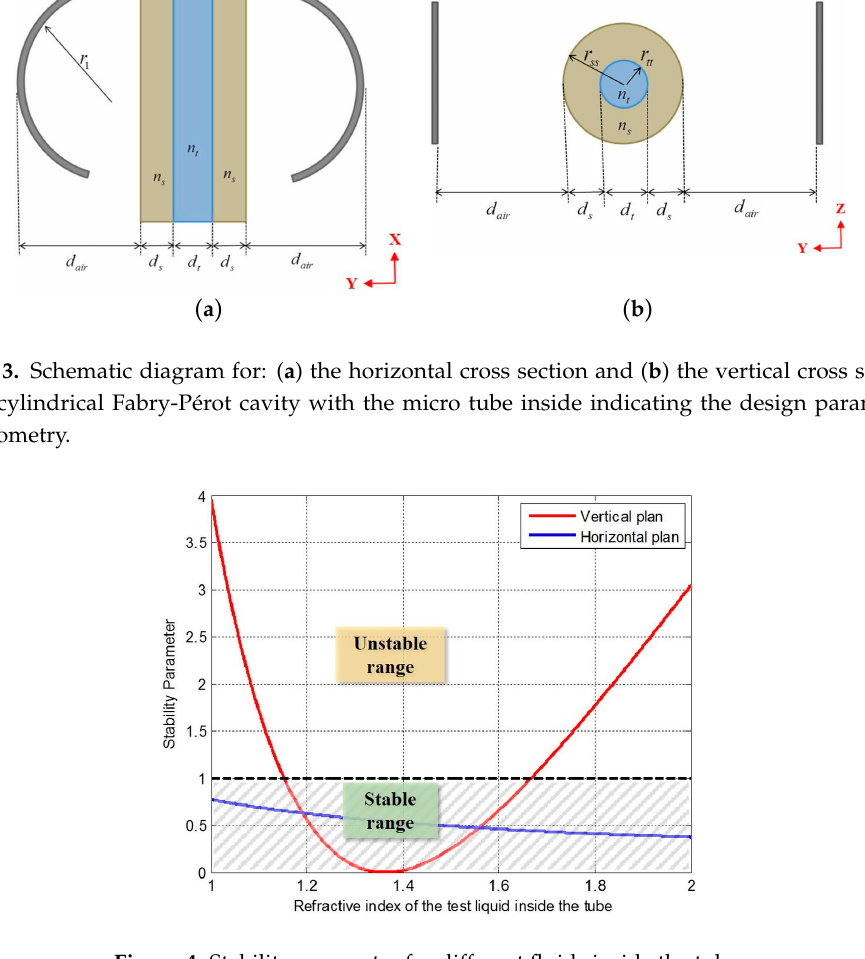
Figure 4. Stability parameter for different fluids inside the tube.